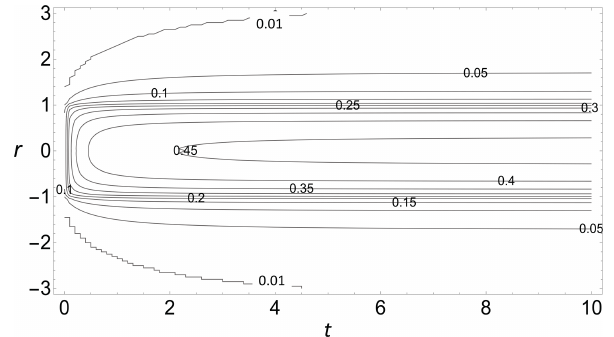
Figure 6. Space–time contours for unit circle forcing as a function of nondimensional time (left to right) and nondimensional horizon- tal distance (vertical